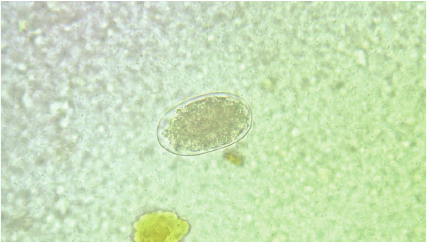
Figure 13: Variably acid-fast Cryptosporidium oocysts and mic- rosporidial spores on modified acid-fast stain, under oil